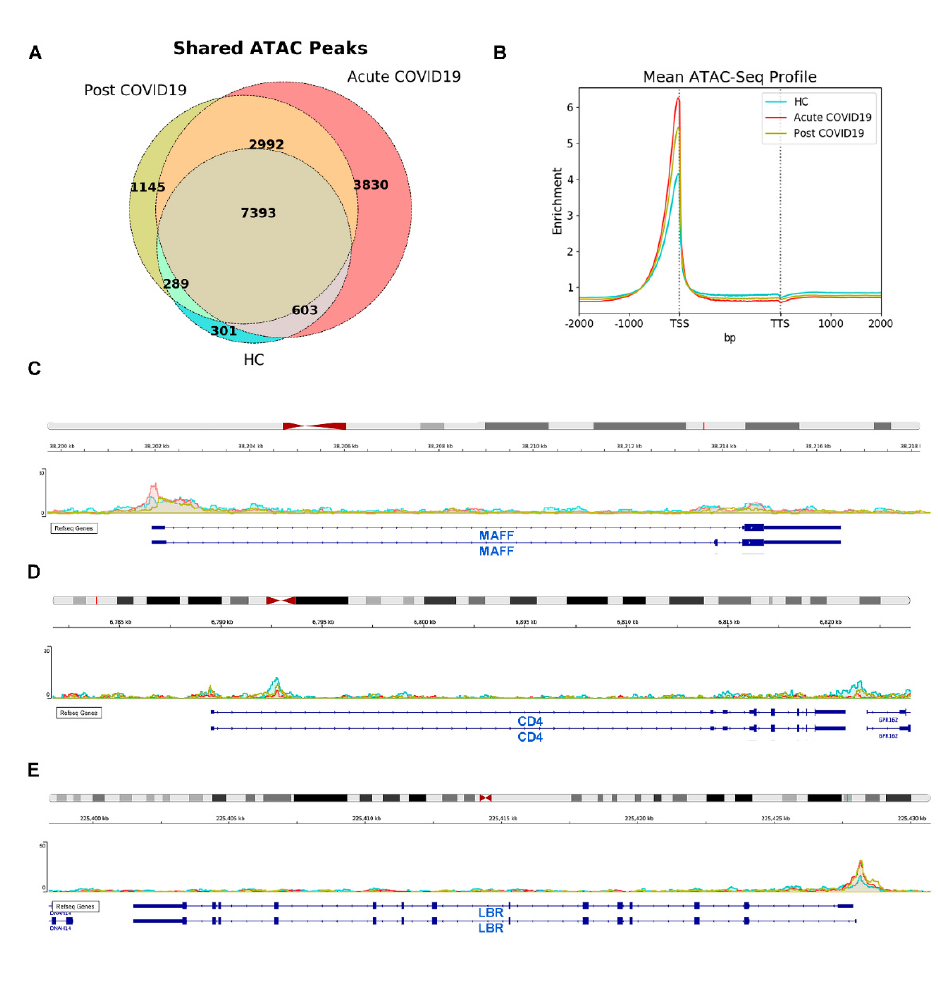
Figure 4. Open chromatin profile is higher in acute, intermediate in post-COVID-19 and lower in HC circulating monocytes. ( A ) Venn diagram of open sites found in HC, acute and post-COVID-19 monocytes. ( B ) Global enrichment sites in HC, acute and post-COVID-19 monocytes. ( C ) MAFF- promoter region had greater opening in acute COVID-19 monocytes. ( D ) CD4-promoter region had greater opening in HC monocytes. ( E ) LBR-promoter region had greater opening in acute and post-COVID-19